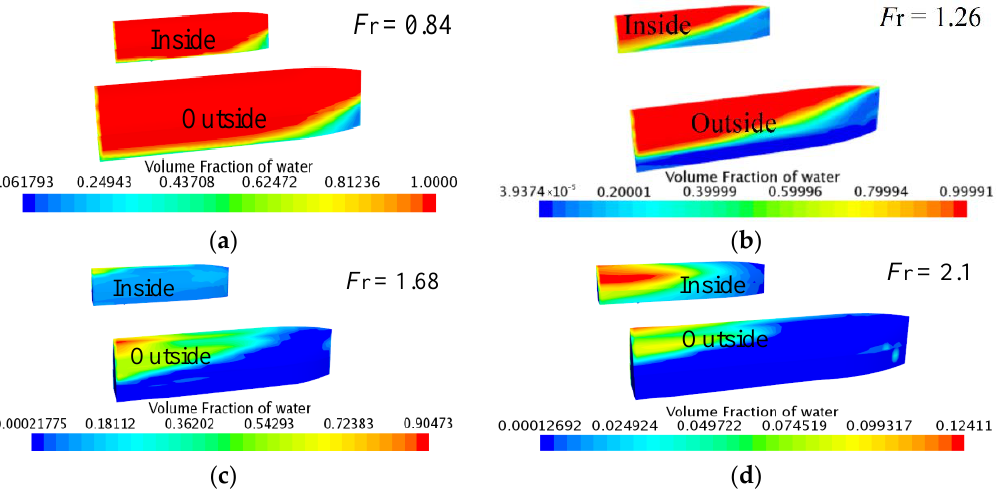
Figure 23. Volume fraction of water for the twin side-hulls at different speeds: ( a ) F r = 0.84; ( b ) F r = 1.26; ( c ) F r = 1.68; ( d ) F r =